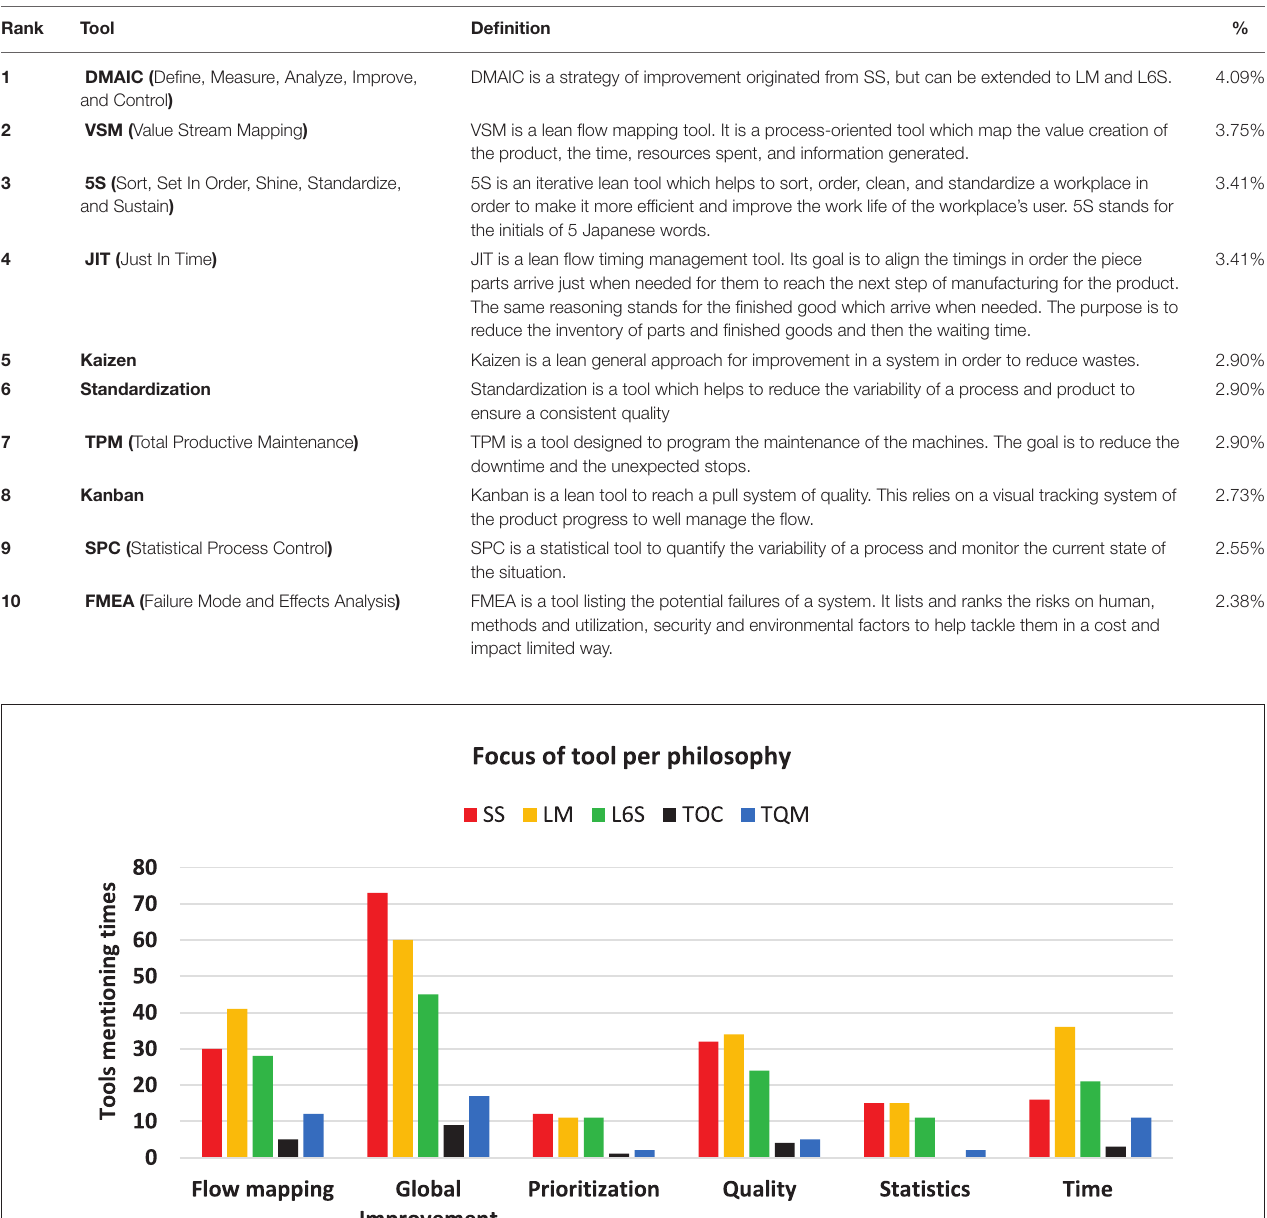
TABLE 5 | Top 10 of listed tools in the literature review.